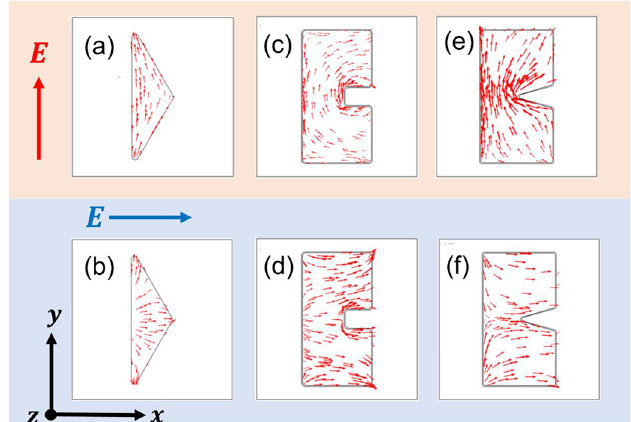
Fig. 6. Inplane arrow plots showing direction of current for Triangle (a,b), SRR (c,d) and Heptagon (e,f) structures at fundamental and SHG resonance, respectively. See Suplementary Material for a dynamic version of this